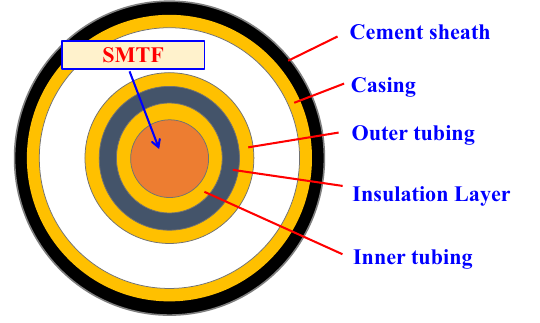
Fig. 1 Vertical section of SMTF flow in wellbores (Sun et al. 2017c, g, h,